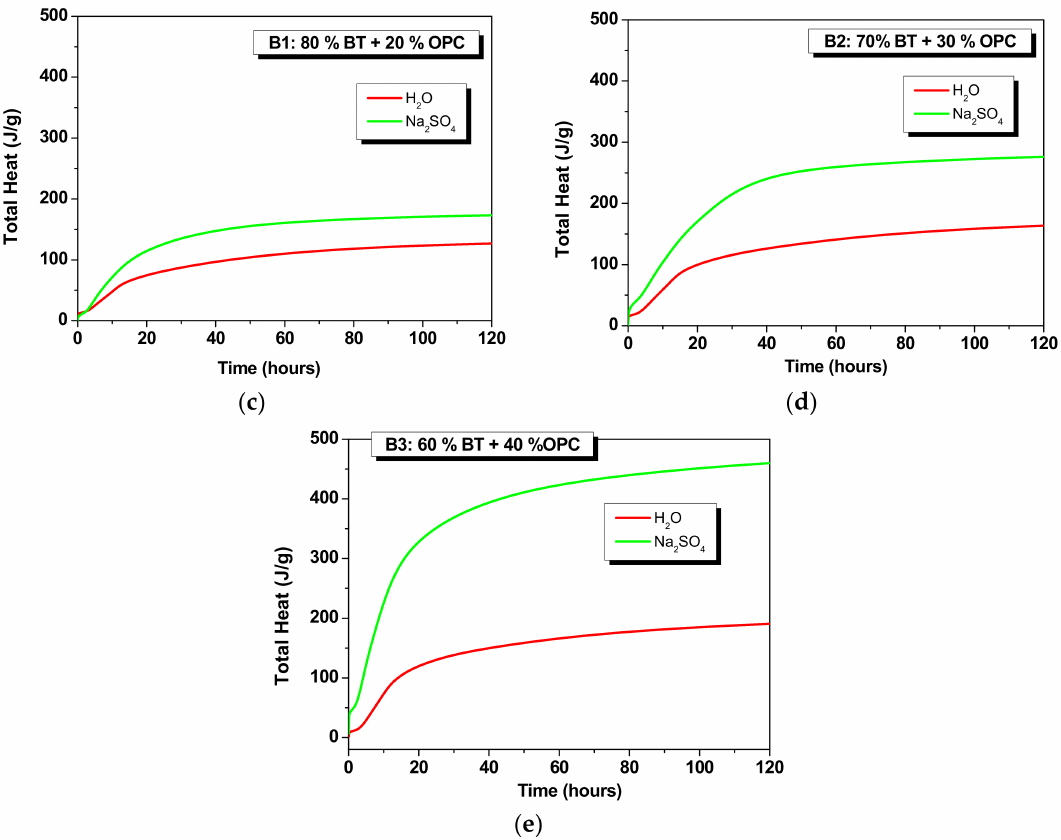
Figure 2. Total Heat (J/g) of hydrated and alkali activated hybrid cements ( a ) BT (100% BT); ( b ) OPC (100% OPC); ( c ) B1 (80% BT + 20% OPC); ( d ) B2 (70% BT + 30% OPC) and ( e ) B3 (60% BT + 40%